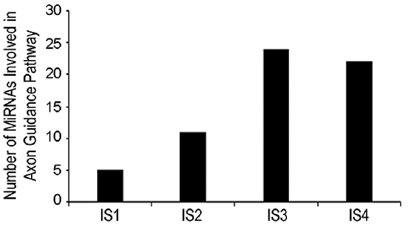
Figure 5. Involvement of significantly modulated miRNA in axon guidance pathway. Quantitative bioinformatics analysis on the number of miRNA involved in the axon guidance pathway was done using IPA. The number of the significantly modulated miRNAs that were predicted to modulate axon guidance pathway increased with the severity of the injury.